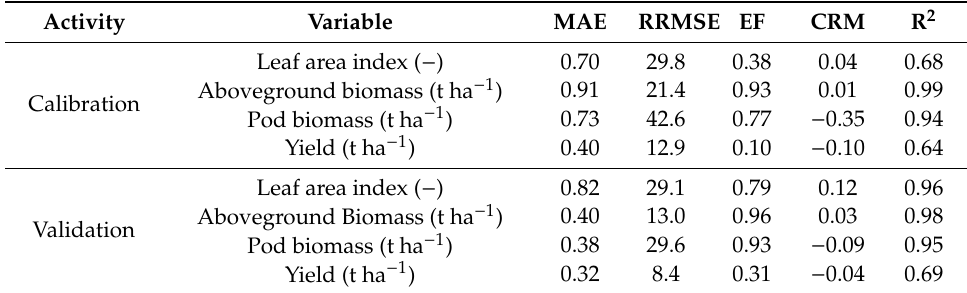
Table 2. Agreement between observed and simulated data for the calibration and validation phase. MAE (same units of the variable): mean absolute error (from 0 to + ∞ , optimum: 0); RRMSE (%): relative root mean square error (from 0 to + ∞ , optimum: 0); EF ( − ): Nash and Sutcli ff e modelling e ffi ciency (from −∞ to 1, optimum: 1); CRM ( − ): coe ffi cient of residual mass (from −∞ to + ∞ , optimum: 0); R 2 ( − ): coe ffi cient of determination (from 0 to 1, optimum: